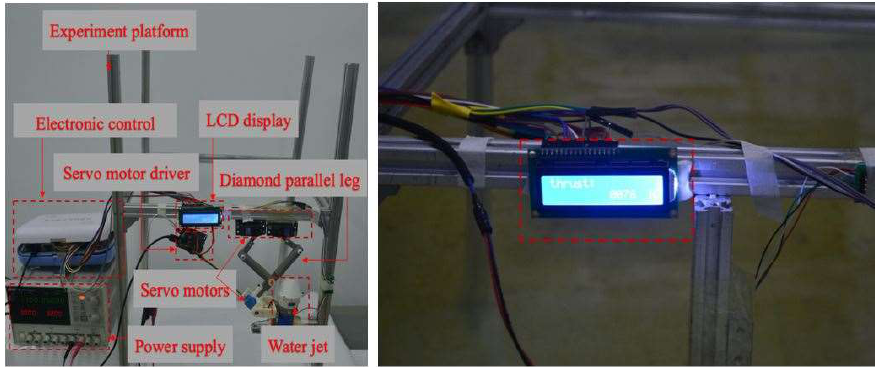
Figure 9. Experimental setup of a diamond parallel leg.